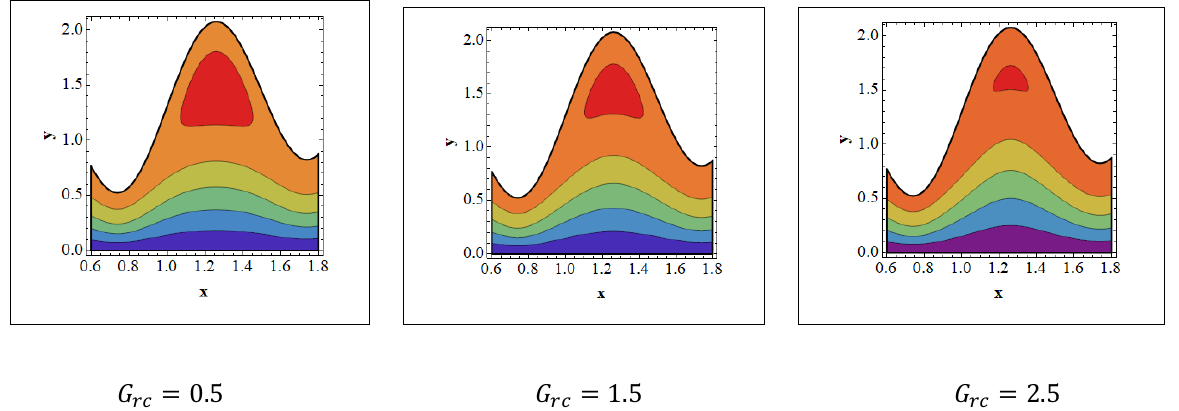
Figure 10. Streamlines for solutal Grashof number. Values of other physical parameters are N t = 0.3, N TC = 1.2, N b = 0.4, b = 0.7, a = 0.3, N CT = 0.9, Re = 0.5, S 1 = 0.3, R m = 0.5, Wi = 1.4, G rt = 0.5, G rF = 0.8, α = 0.8, Q = 3, (cid:101) η = 1, (cid:101) µ =